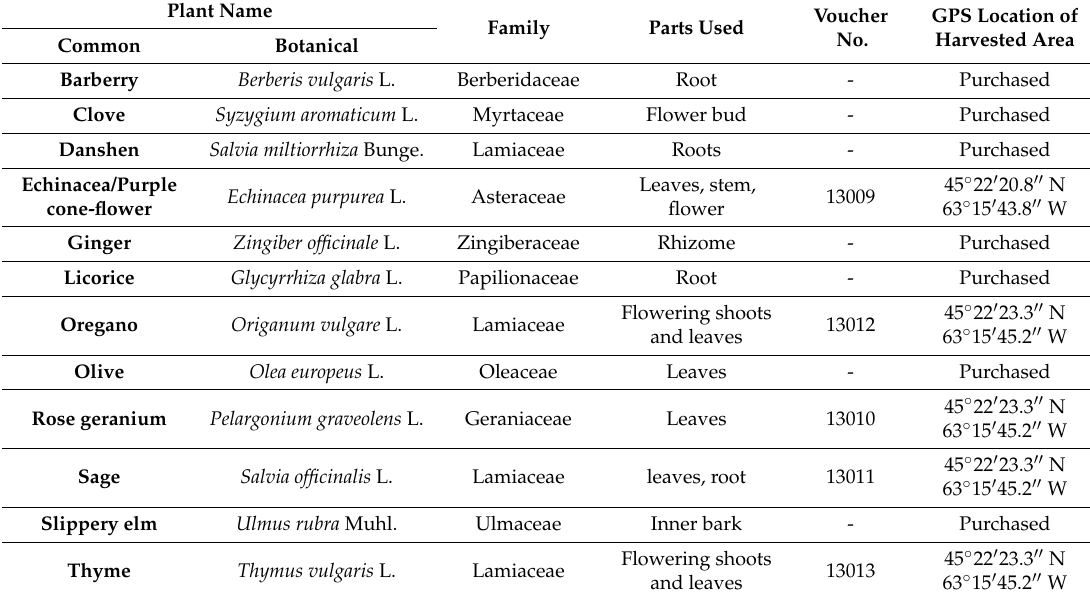
Table 4. The details of the herbal plants used in the